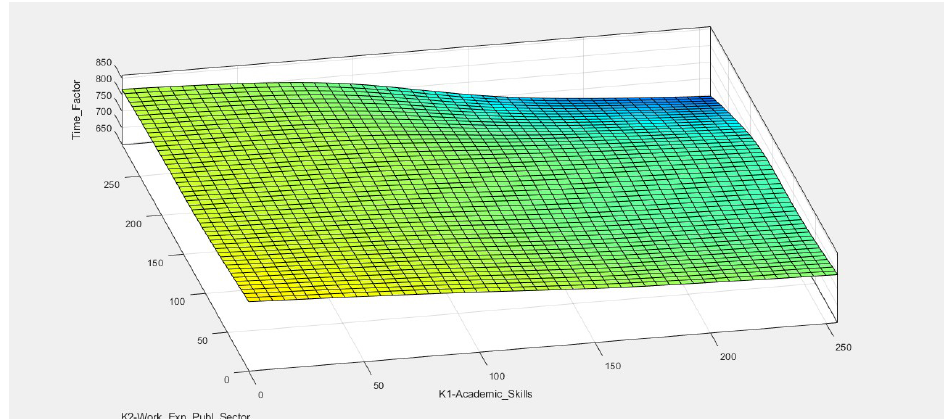
Figure 6. Results of academic skills—work experience in public sector.